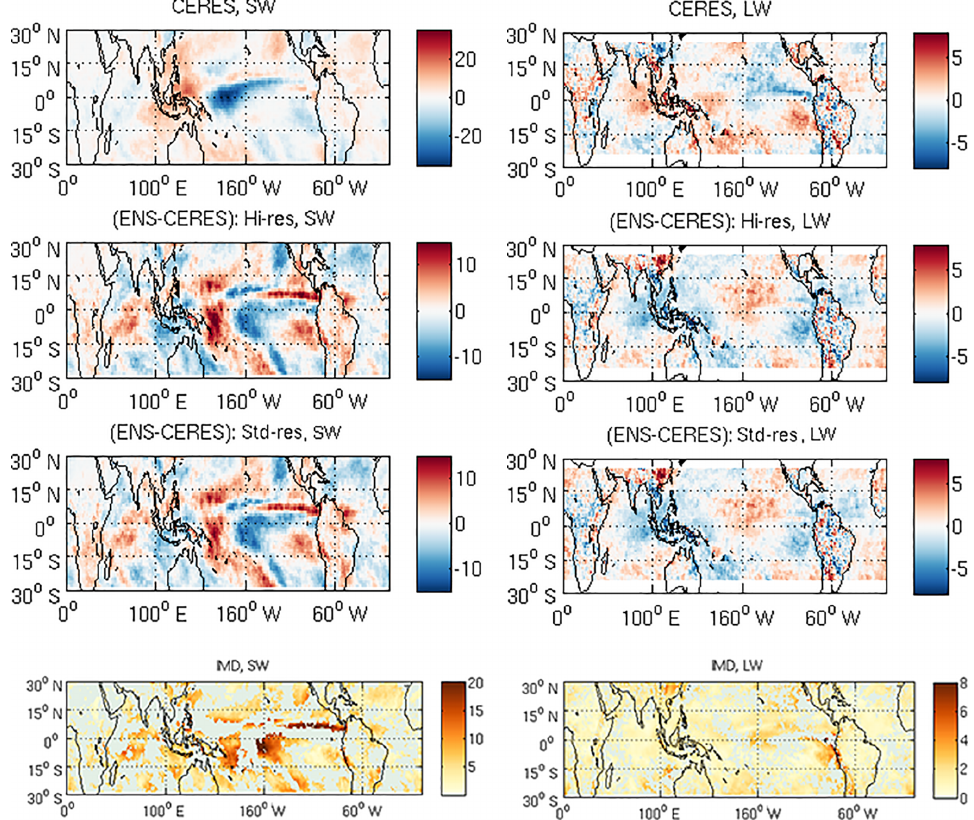
Figure 6. Same as above but for the cloud radiative response at the